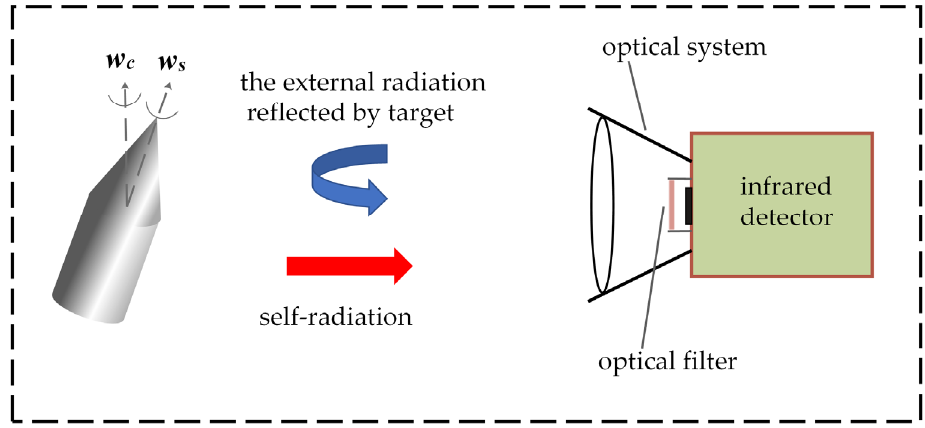
Figure 1. Radiation diagram from the space target to the infrared detector.